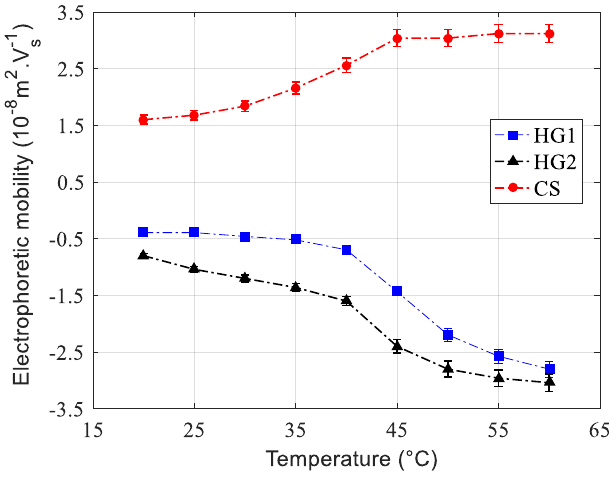
Figure 4. Electrophoretic mobility of HG1, HG2, and CS as a function of temperature at pH=7 in a 10- mM phosphate buffer.